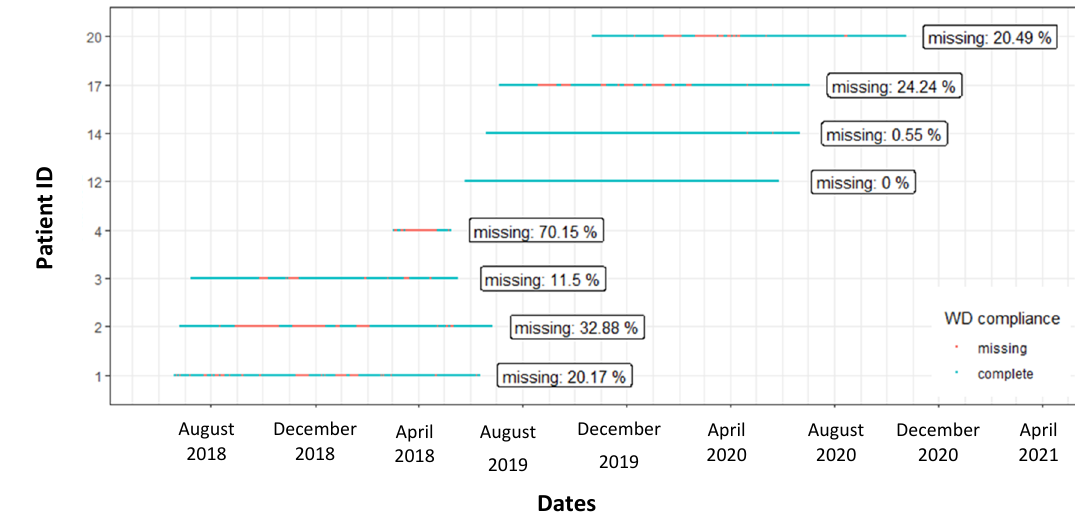
Figure 5. Wearable device wear time for the entire follow-up period for each participant. A line that represents the period of enrolment is reported for each participant, in blue are reported the days without missing data, in red the days with missing data.